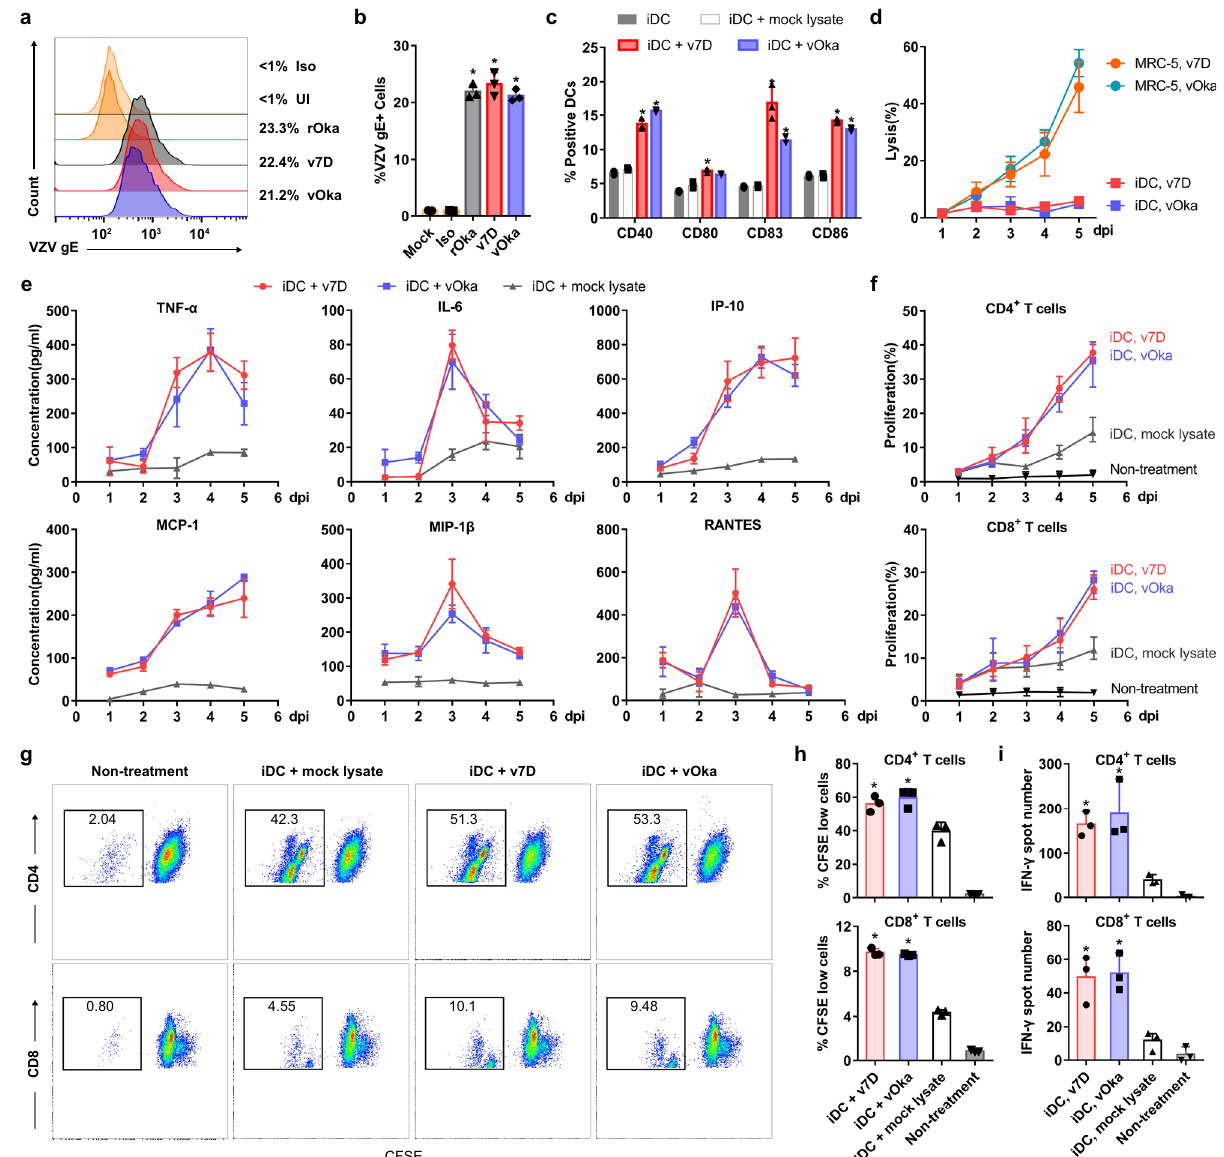
Fig. 4 v7D induces functional activation of human DCs in vitro. Human iDCs were generated from CD14 + monocytes puri fi ed from PBMCs, and were treated with rOka, v7D, vOka (MOI = 0.01) or mock-infected MRC-5 cell lysate as a control. a , b Representative fl ow cytometry data and summary of VZV-gE expression on iDCs at 3 dpi. rOka-infected iDCs were stained with an isotype antibody (iso) as a control. Numbers on the right side of each graph in ( a ) represent the percent of VZV-gE-positive cells. c Flow cytometry analysis of expression of the cell-surface costimulatory markers CD40, CD80, CD83 and CD86 on DCs at 3 dpi. Representative fl ow cytometry data are shown in Supplementary Fig. 5. d Analysis of percent lysis of DCs compared to that of MRC-5 cells after inoculation with v7D and vOka (MOI = 0.01) over fi ve days. e Cytokine/chemokine analysis of DC culture supernatants. f Analysis of cell proliferation rates of the puri fi ed autologous CD4 + and CD8 + T cells after co-culture with antigen-pulsed DCs using the BrdU ELISA assay. g , h Representative fl ow cytometry data and summary data of CFSE dilution among CD4 + and CD8 + T cells after 5-day co-culture with antigen- pulsed DCs. i Analysis of IFN- γ production in CD4 + and CD8 + T cells after 5 days of co-culture with antigen-pulsed DCs using an ELISPOT assay. The results are represented as averages ± the SD ( n = 3 per group). Asterisks denote a signi fi cant difference ( P < 0.05) compared to the mock controls as determined by one-way ( b , h , i ) or two-way ( c ) ANOVA with Tukey ’ s post hoc test. Detailed information about the statistics and values are provided in Supplementary Table 3. The experiments were repeated twice using cells from six donors, and representative results are shown. Source data are provided as a Source Data fi